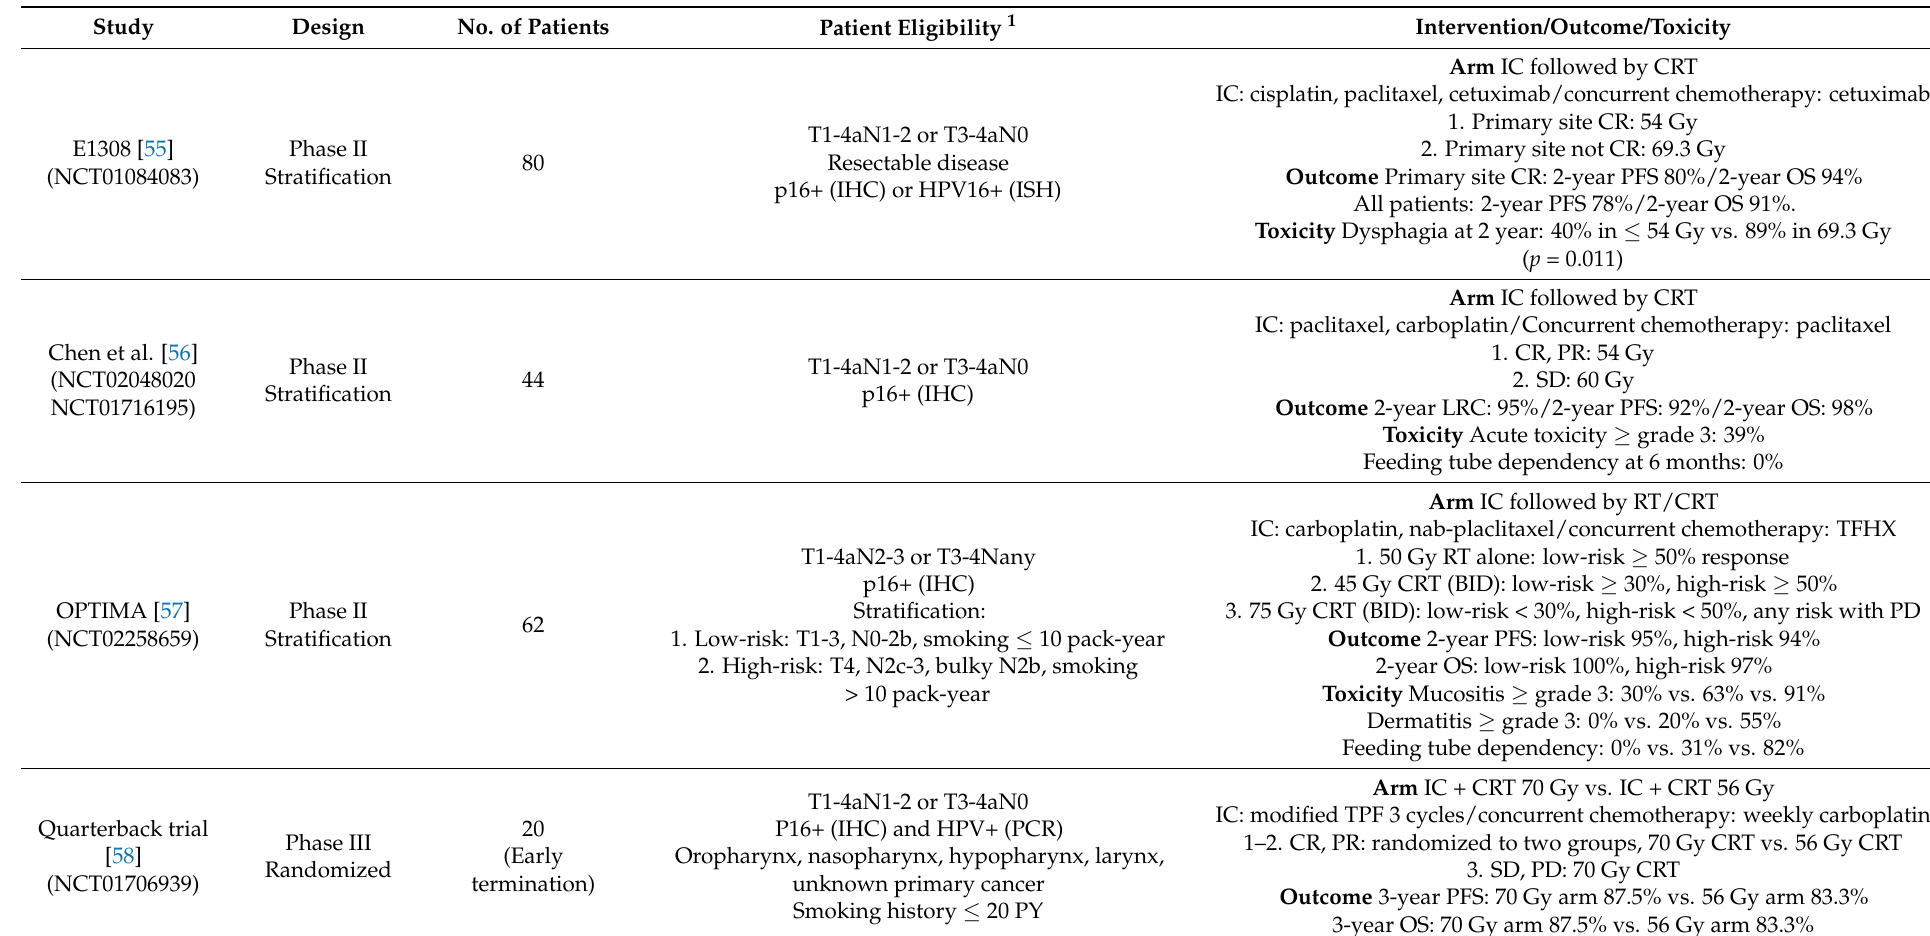
Table 2. Deintensification in response to induction chemotherapy